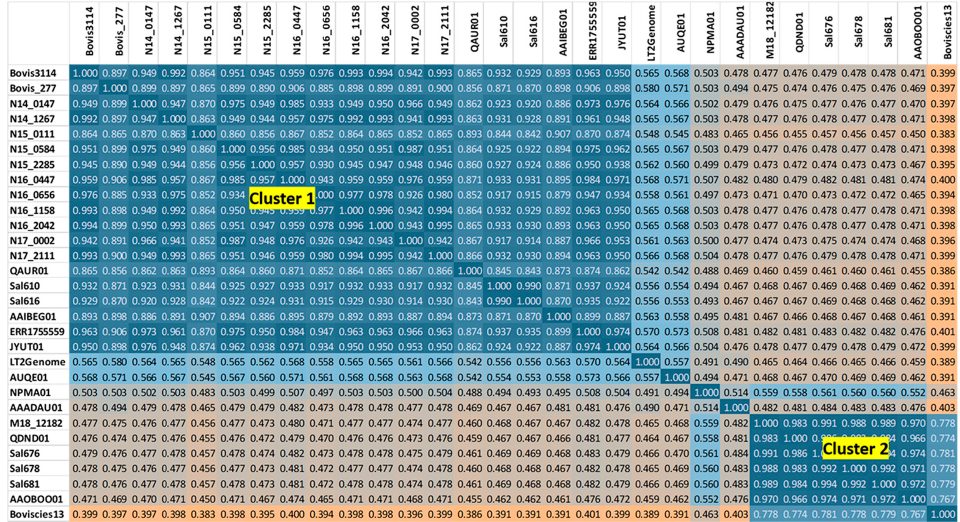
Figure 3. k-mer -binning analysis of genomes from S . Bovismorbificans and closely related serovars. A snap shot of the Jaccard index from the k-mer -binning analysis ( k = 30) of 330 WGS assemblies dataset from five Salmonella serovars was illustrated (Heatmap orange to teal blue = most divergent to most similar). S . Typhimurium (LT2Genome) and S . Muenchen (AUQE01) are closer to Cluster 1 strains (shown in sky blue), and S . Takoradi (NPMA01) is the closest serovar to the ST150 Cluster 2 strains (shown in tan). Distinct genomic pathotypes of the two S . Bovismorbificans clusters suggest evolutionarily independent hinging of a single serotyping gene cluster (“8:r:1,5”) in two different lineages of SE with different genomic backbones. The complete phylogenomic analysis with 330 genomes is presented as Supplemental File S4.